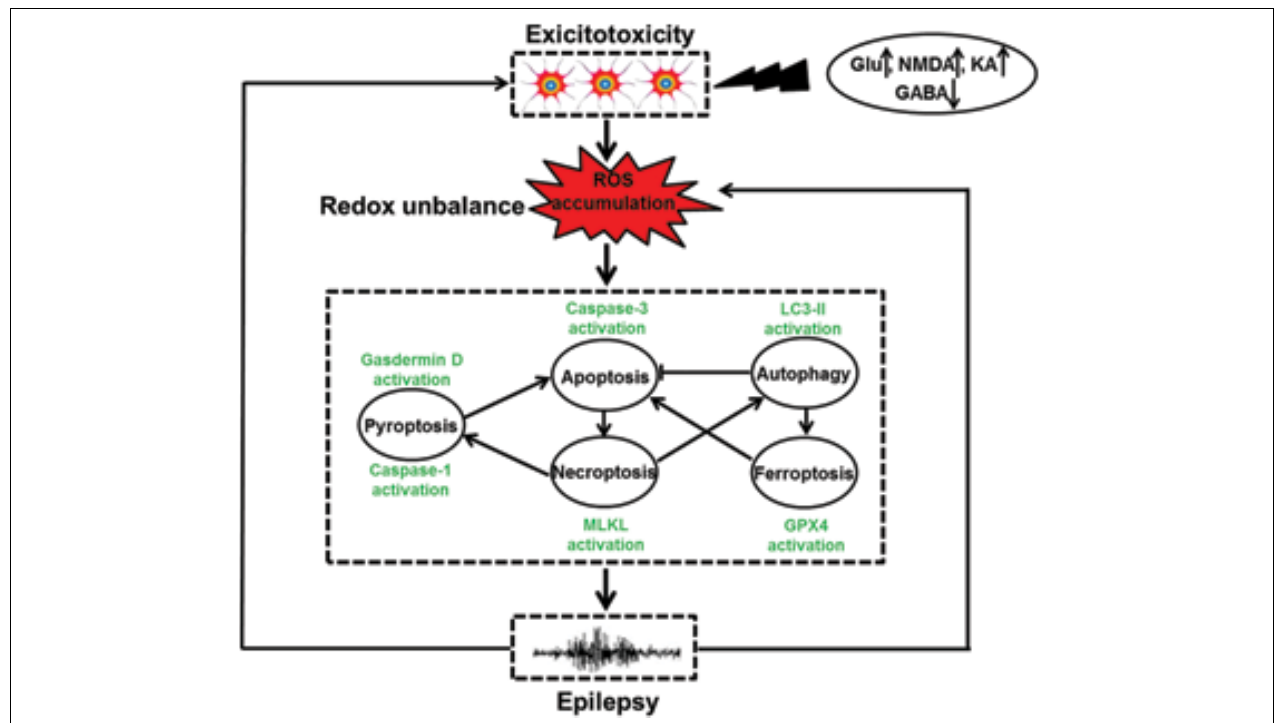
FIGURE 1 | The relationship of redox-related cell death and epilepsy. Under the exposure of toxins, such as high levels of Glu, NMDA, and KA as well as low GABA content, neuronal hyperexcitation occurs, leading to ROS accumulation. Oxidative stress induced by redox unbalance then leads to multiple types of redox-associated neuronal death modes including apoptosis, autophagy, necroptosis, pyroptosis, and ferroptosis by activating caspase-3, LC3II expression, MLKL phosphorylation, caspase-1 activation and Gpx4 activity, respectively. Within a cell, the molecular crosstalk of these cell death modalities occurs, which ultimately triggers dead neuron phenotype and provokes epilepsy. Meanwhile, the recurrent epileptic seizures also have the capacity of exacerbating neuronal excitotoxicity and overproduction of ROS, shaping a vicious